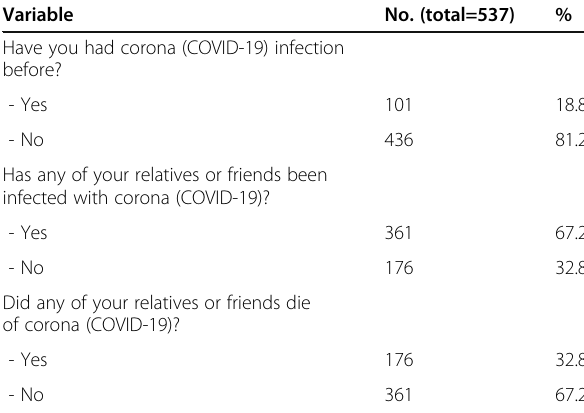
Table 2 COVID-19 infections among male students at Al-Azhar Faculty of Medicine, Cairo, Egypt, 2021, and their families ’ or relatives ’ infection or